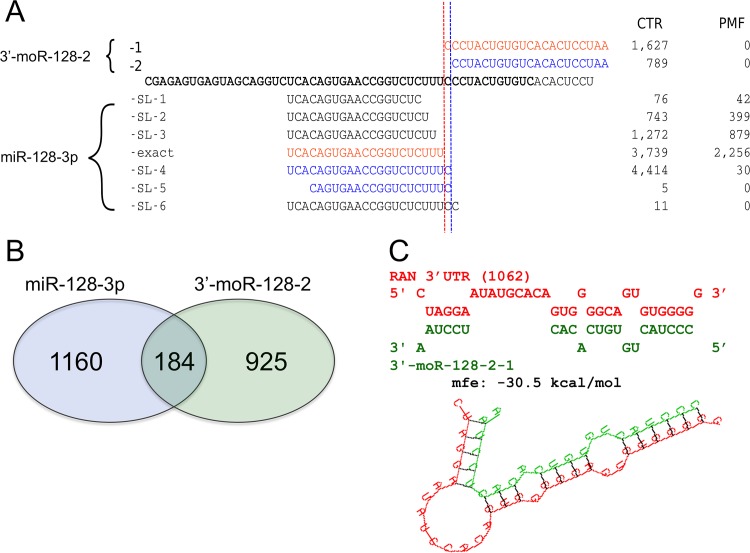
Origin, sequence variability, and relations beween 3’-moR-128-2 and the adjacent miR-128-3p.A) 3’-moR-128-2 and miR-128-3p map to the same locus and both shows sequence variability (isomiRs and isomoRs). Both the major and the minor isomoRs are found in normal CD34+ cells and not in PMF samples. Red and blue colors indicate isomiR and isomoR groups that can be produced with an unique sequence cutting sites. The most expressed isomoR is not associated to the corresponding most expressed isomiR. Moreover, expression levels, in CTR and PMF samples, of isomiRs and isomoRs are poorly correlated intragroup. These observations, point against the moRNA being simply a by-product of the miRNA biogenesis. A similar indication is given by the fact that some abundant isomiRs are not associated to detected isomoR sequences. B) 3’-moR-128-2 and miR-128-3p have different, poorly overlapping, sets of predicted targets. C) 3’-moR-128-2 sequence can stably bind a target site in the 3’UTR of the RAN mRNA, causing post transcriptional silencing.